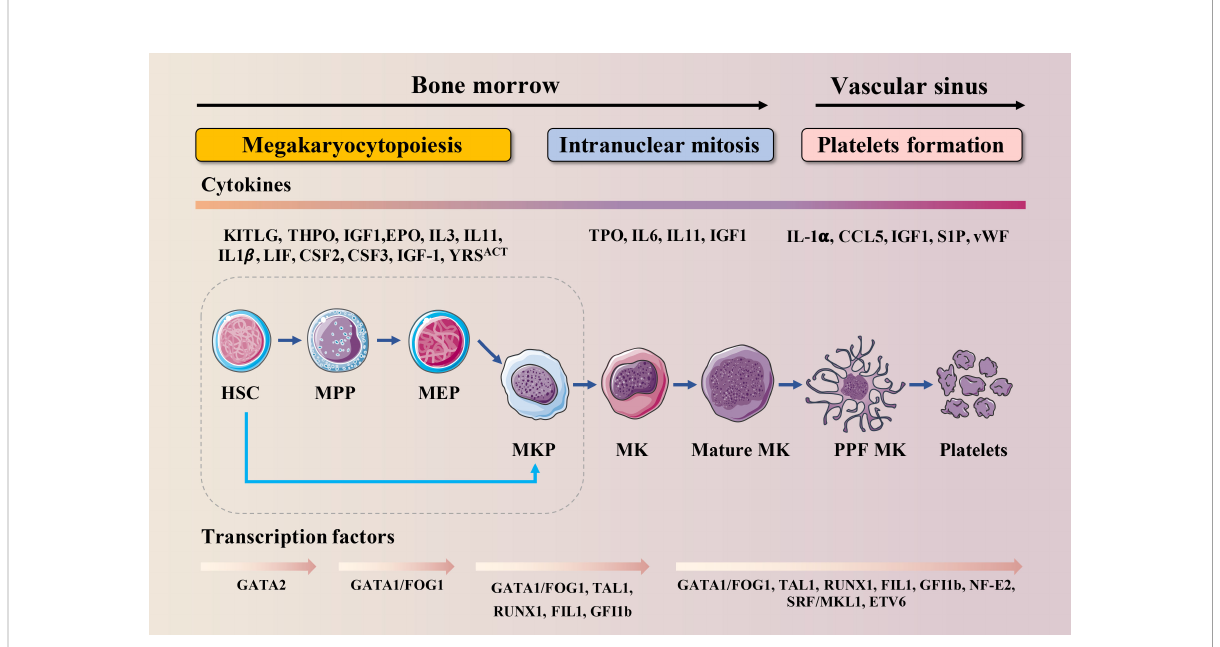
FIGURE 1 Schematic illustration of MK lineage commitment, intranuclear mitosis and maturation and platelet formation. This drawing depicts the essential developmental stages of thrombopoiesis. MKs originate from HSCs in the bone marrow. Developing MKs undergo intranuclear mitosis to increase chromosome number, then mature before migrating to the vascular sinus where they extend proplatelets or migrate themselves across the endothelial cell barrier into the vascular sinus. These events require the interaction of various cytokines with their receptors and are regulated by multiple transcription